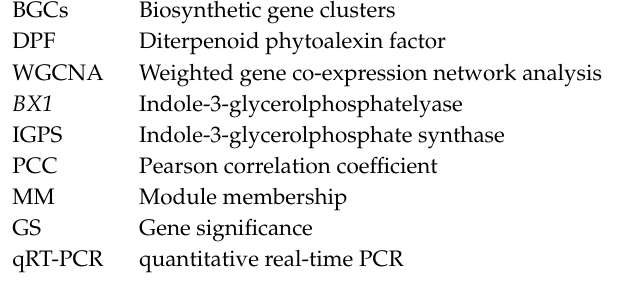
Table S1: Summary of the RNA-seq data for rice and baryardgrass in this study. Table S2: Predicted candidate biosynthetic gene clusters in the rice and barnyardgrass genomes. Table S3: GO enrichment for genes in the gene modules associated with the expression of the DIMBOA and momilactone gene clusters in barnyardgrass. Table S4: MapMan functional enrichment for genes in the gene modules associated with the expression of the DIMBOA and momilactone gene clusters in barnyardgrass. Table S5: Top 30 hub genes for each module associated with the DIMBOA and momilactone cluster in barnyardgrass. Table S6: Functional enrichment for the rice MEroyalblue module. Table S7: Hub TFs in the modules associated with the momilactone and phytocassane cluster in rice. Table S8: Primers used in qRT-PCR in this